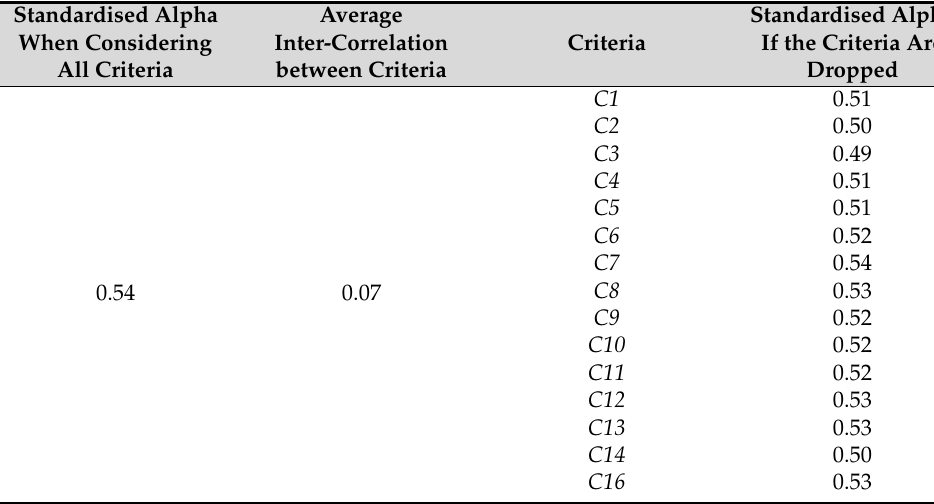
Table 3. Cronbach’s alpha for the variables characterising FOI